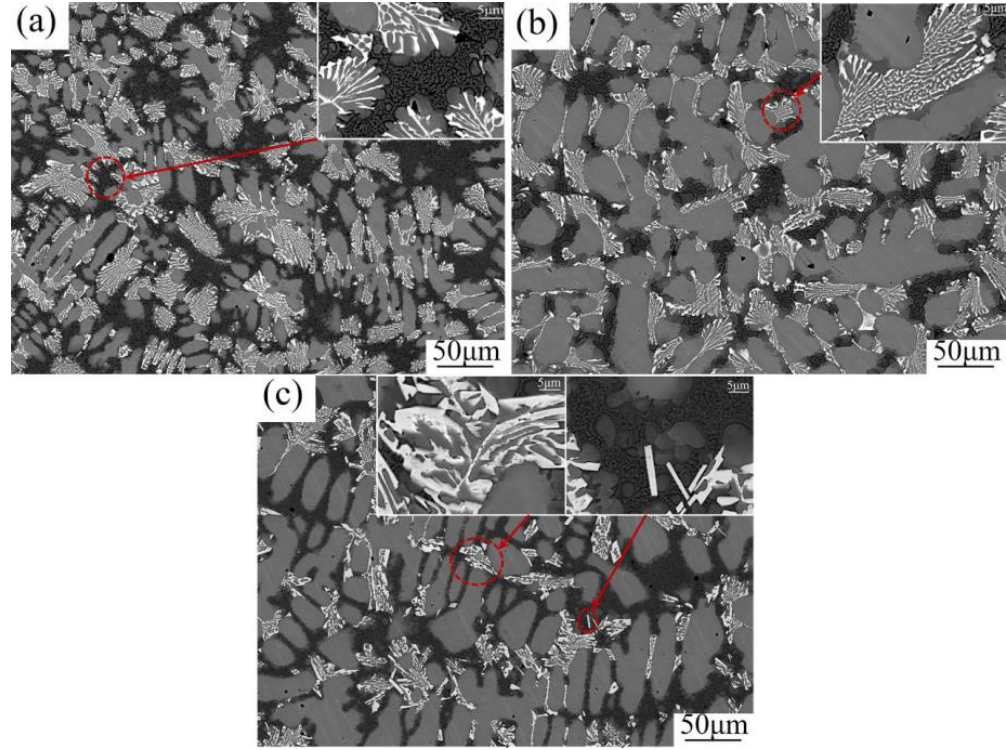
Figure 4. The phase morphology after various isothermal treatment temperatures of Ni-Cr-W superalloy: ( a ) 1410 °C; ( b ) 1400 °C; ( c ) 1390 °C.